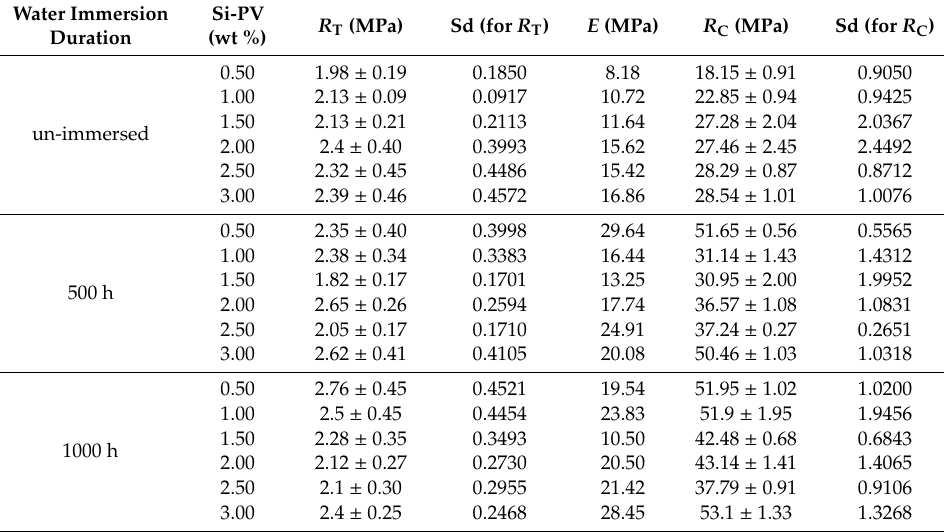
Table 2. Mechanical properties of all-waste polymer composites with low Si-PV content. Water Immersion Si-PV R T (MPa) Sd (for R T ) E (MPa) R C (MPa) Sd (for R C ) Duration (wt %) 0.50 1.98 ± un-immersed